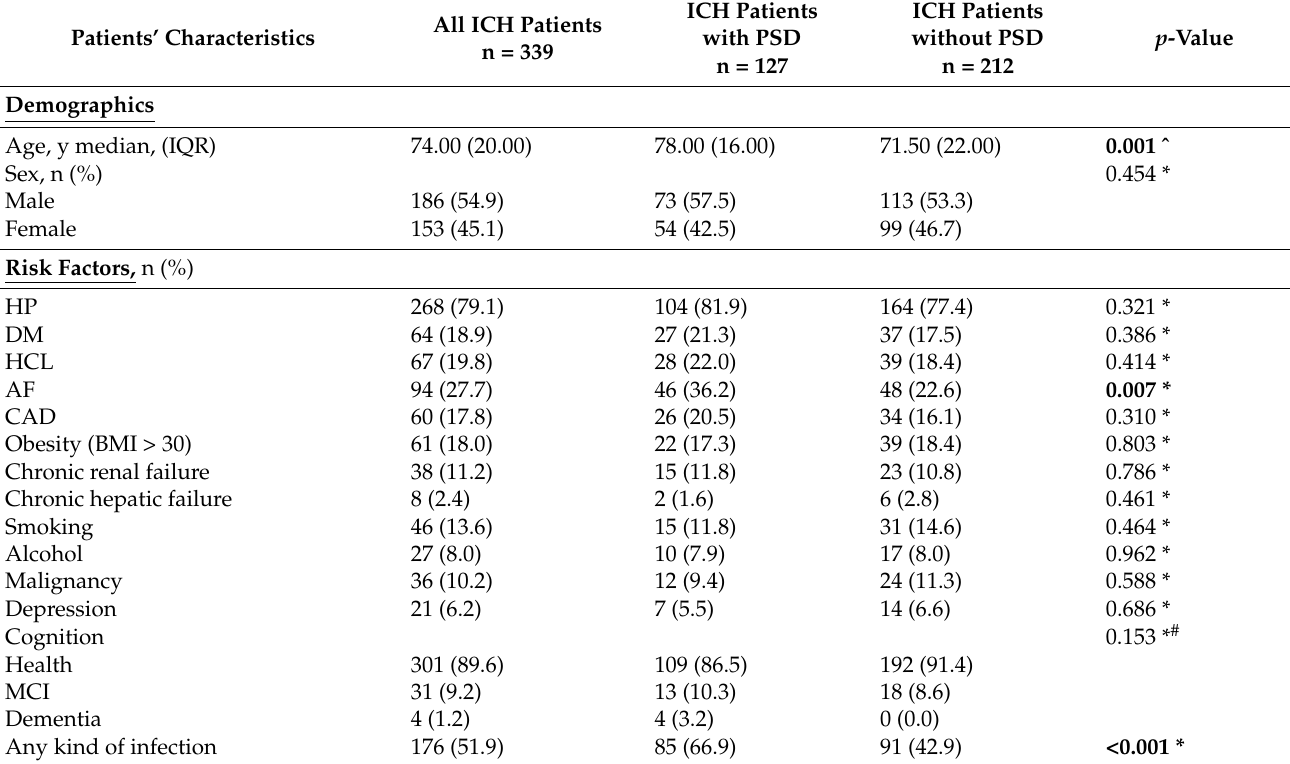
Table 1. Characteristics of patients with